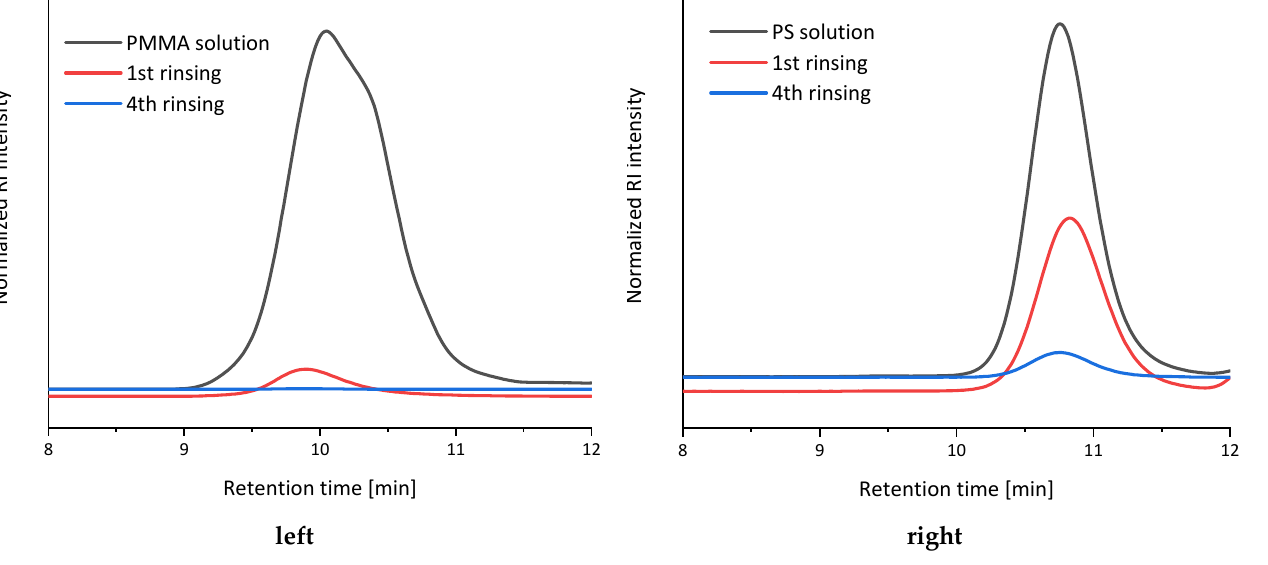
Figure 2. SEC-Elugram of dialysis tubing reusability tests. ( left ) PMMA ( P5 ) solution. ( right ) PS ( P6 ) solution. Black: Raw polymeric solution. Red: 1st rinsing fraction. Blue: 4th rinsing fraction.